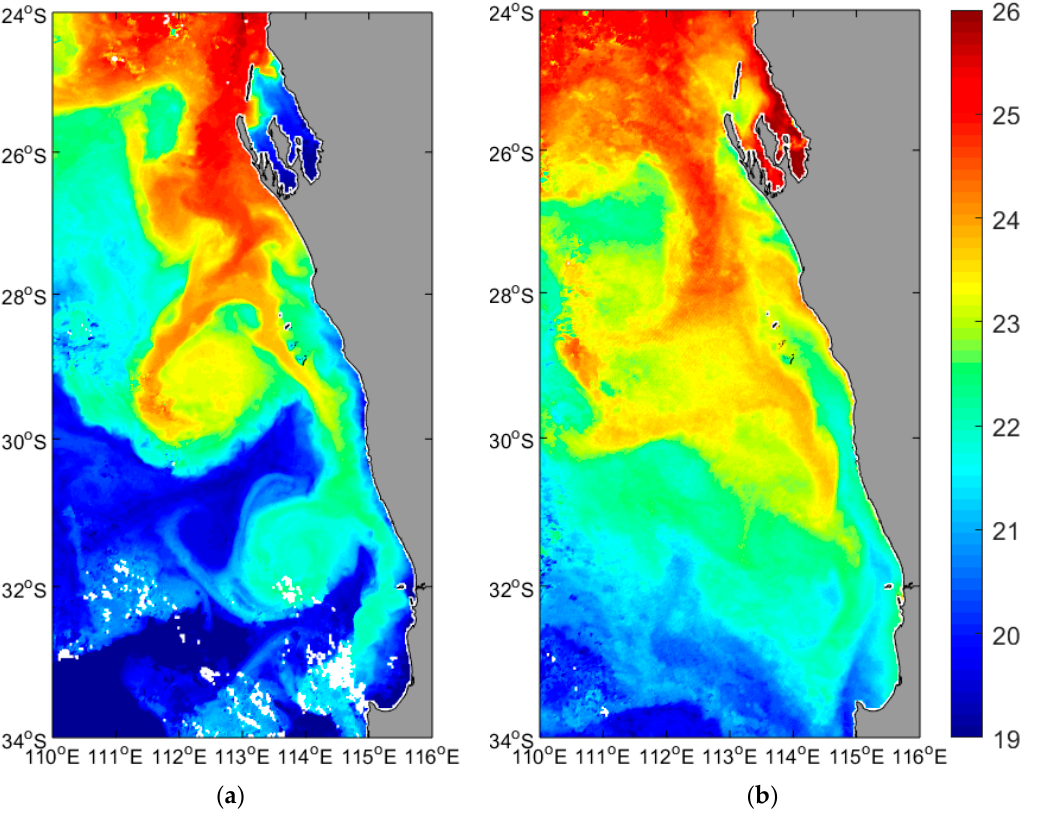
Figure 1. Satellite derived sea surface temperature distribution (°C) during: ( a ) winter (28 May 2018); and, ( b ) summer (23 February 2016) indicating the eddy systems of the Leeuwin Current (LC) and colder Capes Current (CC). Sea surface temperature (SST) data originated from the multi-sensor Australian Integrated Marine Observing System (IMOS) L3S foundation SST product.